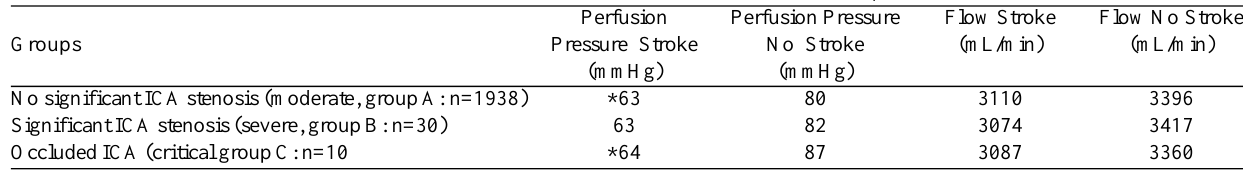
Table 4. Mean Perfusion Pressure and Flow in Patients with/without Stroke in Different Groups. Groups No significant ICA stenosis (moderate, group A: n=1938) Significant ICA stenosis (severe, group B: